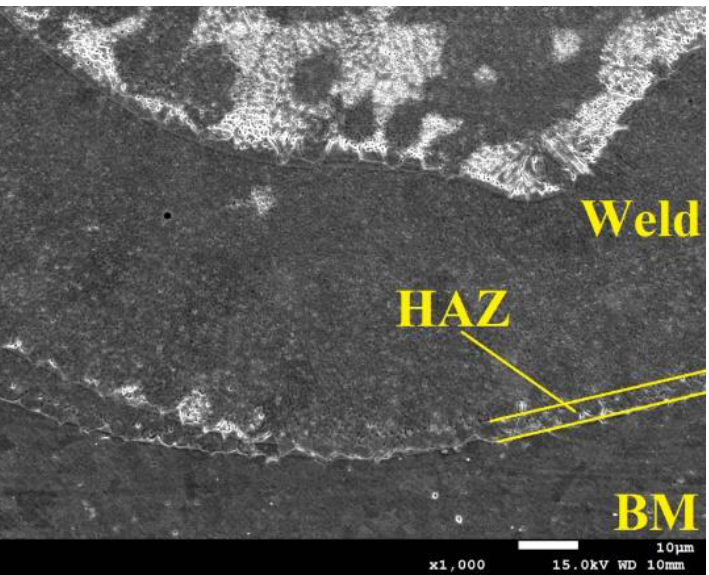
Figure 7. The fusion penetration line zone of the weld into the base material. Within area 3, the presence of a heat-affected zone was identified, and no clear